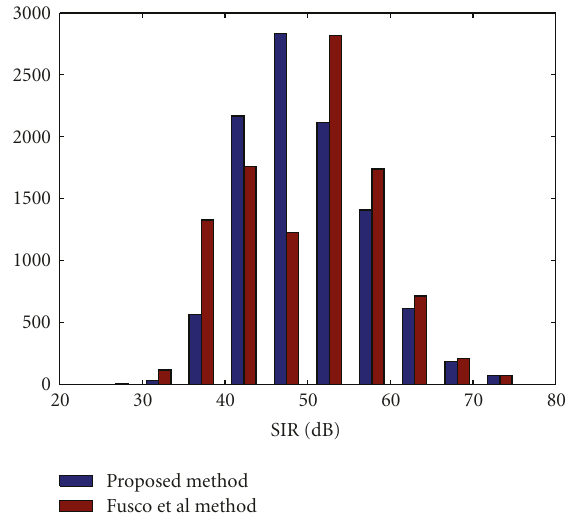
Figure 9: SIR comparison of (16) and (17). The histograms are based on testing over 10000 randomly generated channels.